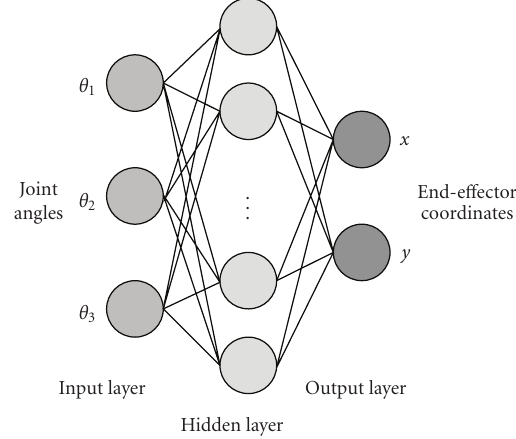
Figure 3: Iterative update of input from provided output by network inversion.